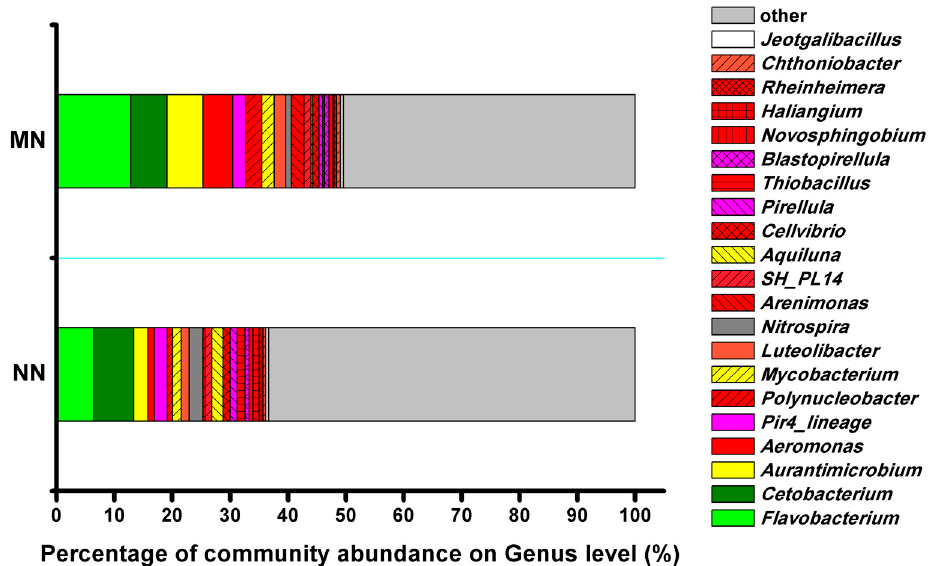
Figure 4. Microbial composition during the experiment. OTU analysis based on the genus level. The same color on the genus level indicates from same phylum (n = 3). Table 4. Primary bacterial composition in the experimental aquaponic system. OTU analysis based on the genus level.